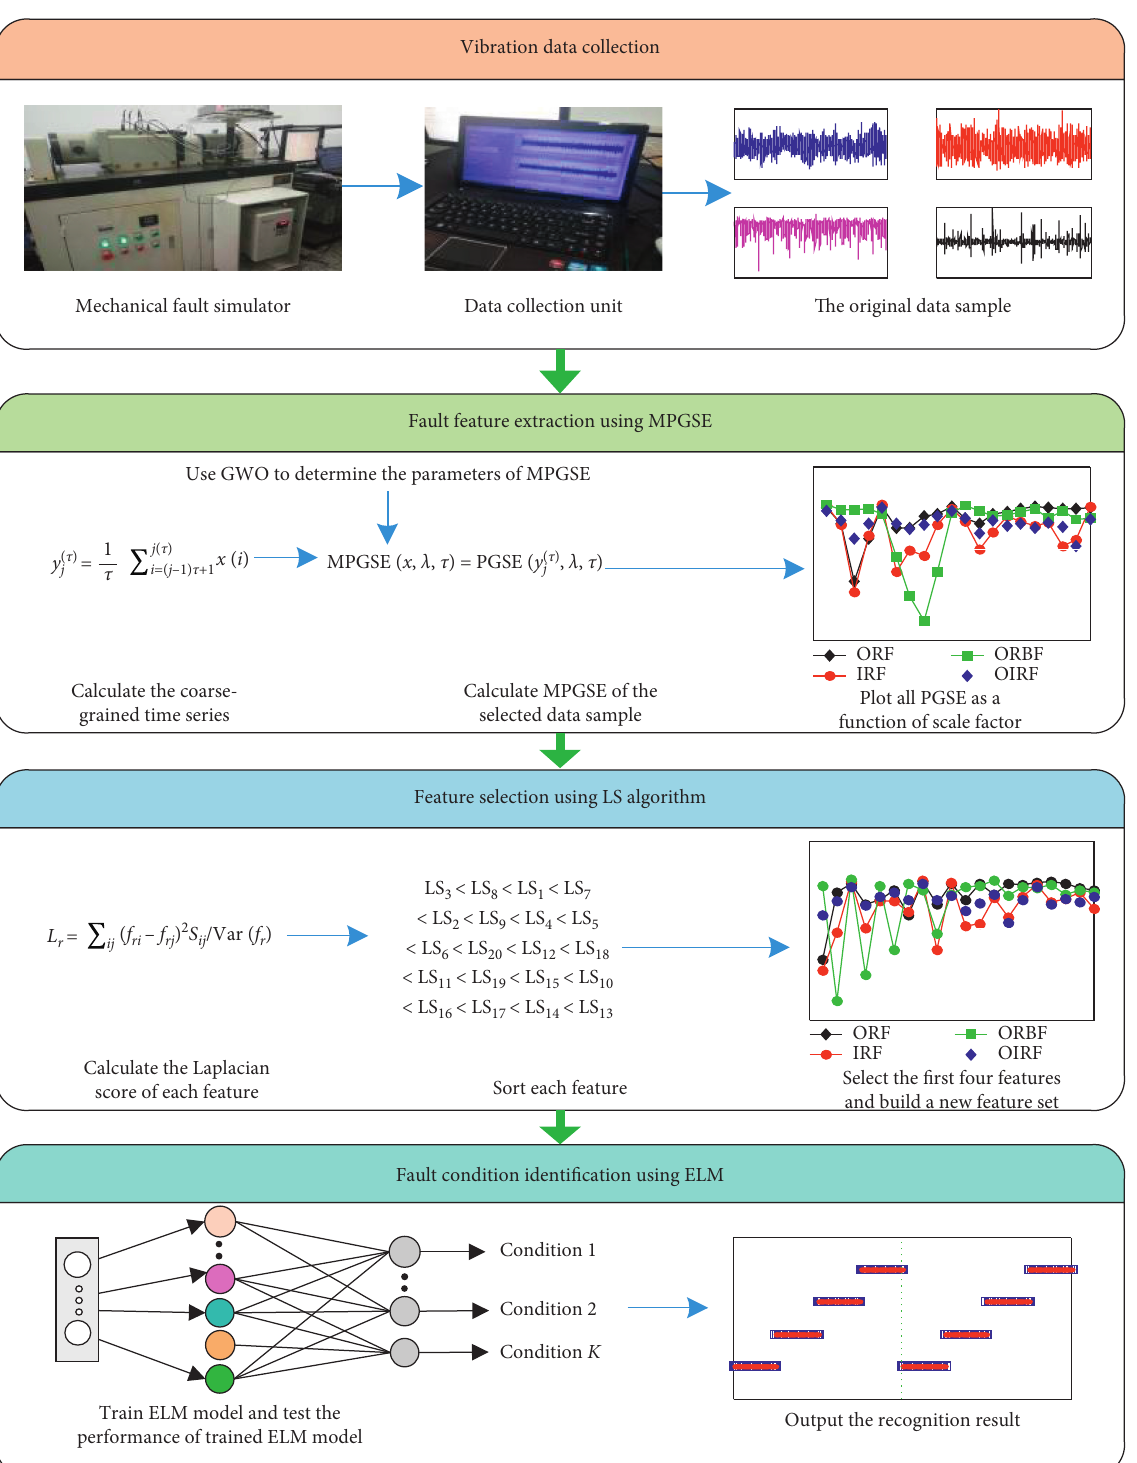
Figure 12: Flowchart of the proposed